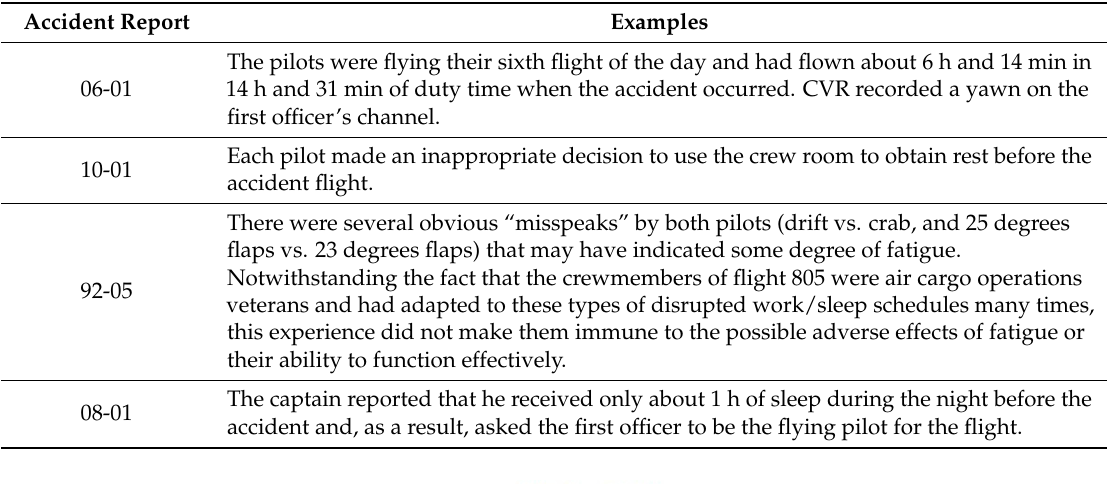
Table 12. Examples of fatigue as a contributing factor.